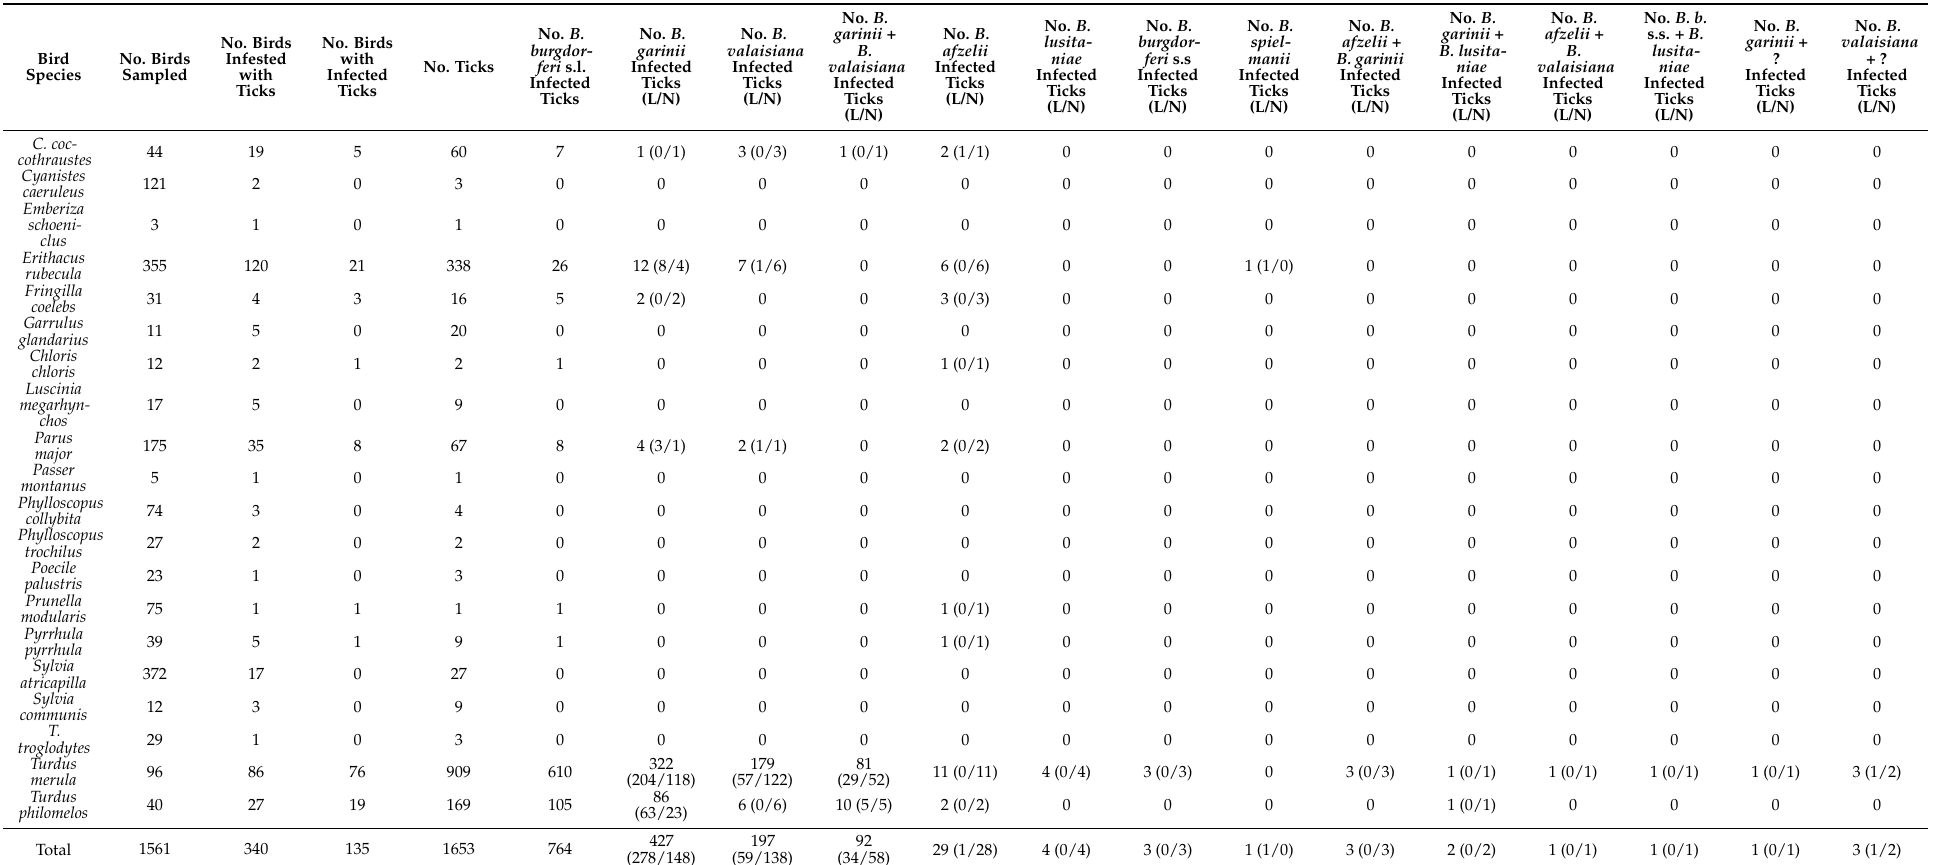
Table 1. Prevalence of Borrelia burgdorferi s.l. in Ixodes ricinus ticks feeding on birds in Slovakia, 2017–2019. L and N refer to larvae and nymphs, respectively. Restriction Fragment Length Polymorphism (RFLP) was used to diagnose the genospecies of